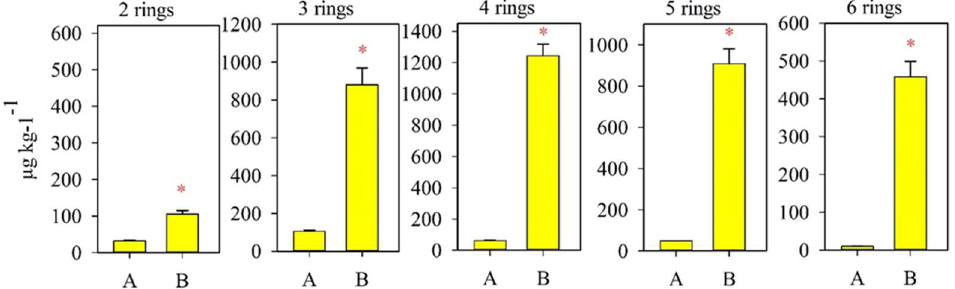
Figure 2. The content of PAHs with different amounts of benzene rings in the soils of the monitoring sites. Asterisks denote the significance of difference between PAH content in studied sites.